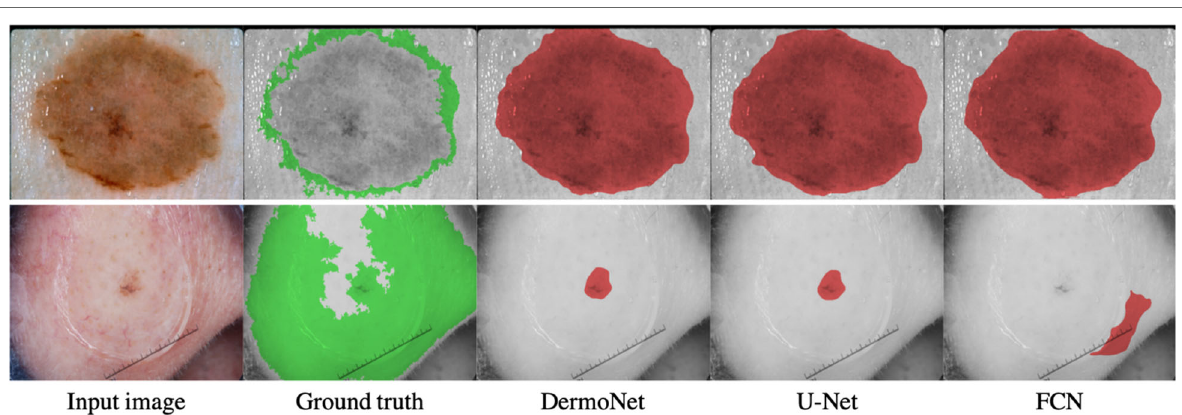
Fig. 6 Cases where all segmentation methods failed (mis-segmentation)